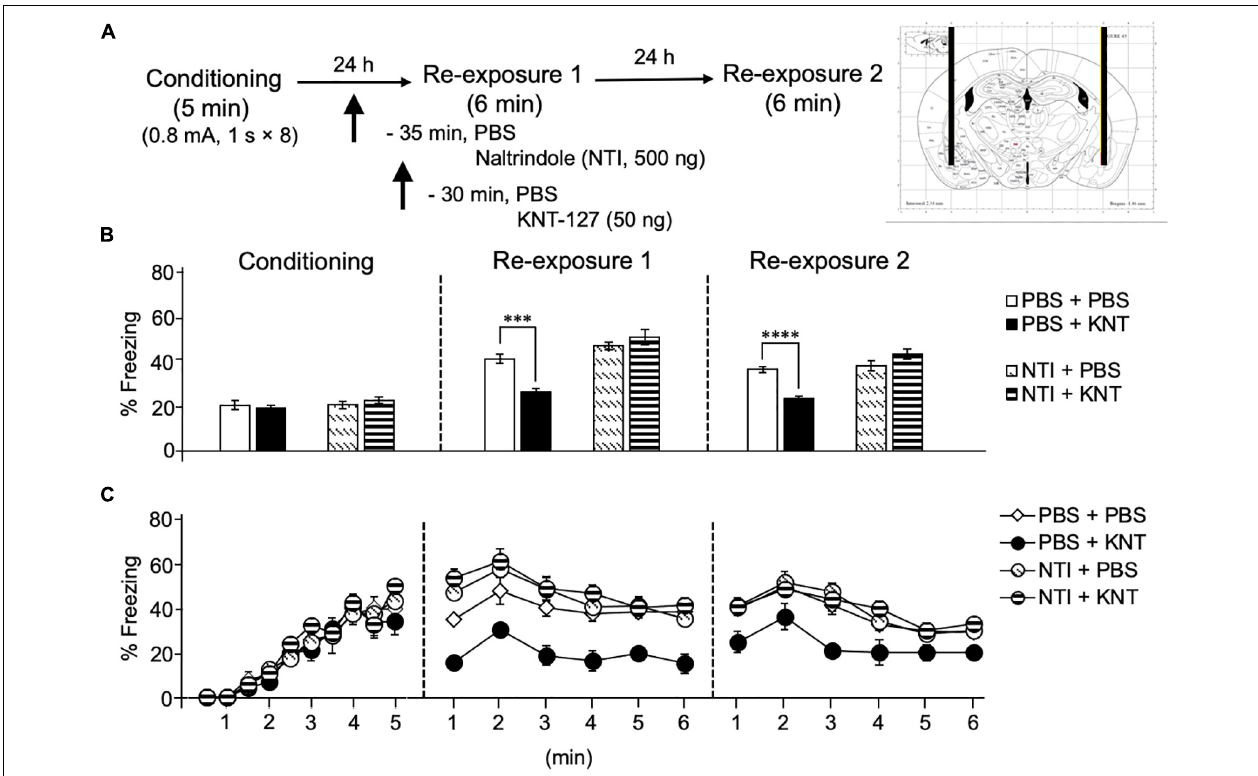
FIGURE 2 | Intra-BLA administration of the DOP antagonist abolished the freezing reduction by KNT-127. (A) Experimental design. Mice were bilaterally administered with PBS or KNT-127 (50 ng) into the BLA 30 min before reexposure 1 (6 min). Five minutes before injecting these drugs, PBS or a DOP antagonist, naltrindole (NTI), was administered similarly (35 min before reexposure 1). Twenty-four hours after reexposure 1, a fear memory was tested in the same context for 6 min (reexposure 2). (B) Freezing rates of mice during conditioning, reexposures 1 and 2. I abolished the effects of KNT-127 during reexposures 1 and 2. The number of mice in each group was as follows: n = 9 for PBS and subsequent PBS (PBS + PBS), n = 6 for PBS and subsequent KNT-127 (PBS + KNT), n = 8 for NTI and subsequent PBS (NTI + PBS), and n = 8 for NTI and subsequent KNT-127 (NTI + KNT). (C) Time course of the freezing rates of mice during conditioning, reexposures 1 and 2. Data are expressed as the means ± SEM. Data were expressed as mean ± SEM. ∗∗∗ p < 0.001, ∗∗∗∗ p < 0.0001 for comparisons between KNT and NTI treatment groups by one-way or two-way ANOVA and post hoc Bonferroni’s